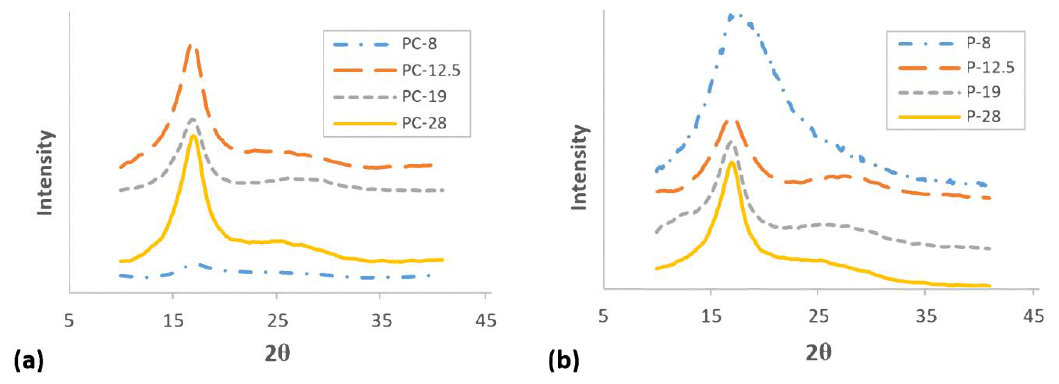
Figure 5. XRD patterns of fibers spun at different shear rates. ( a ) PAN/CNT fibers, ( b ) PAN fibers.